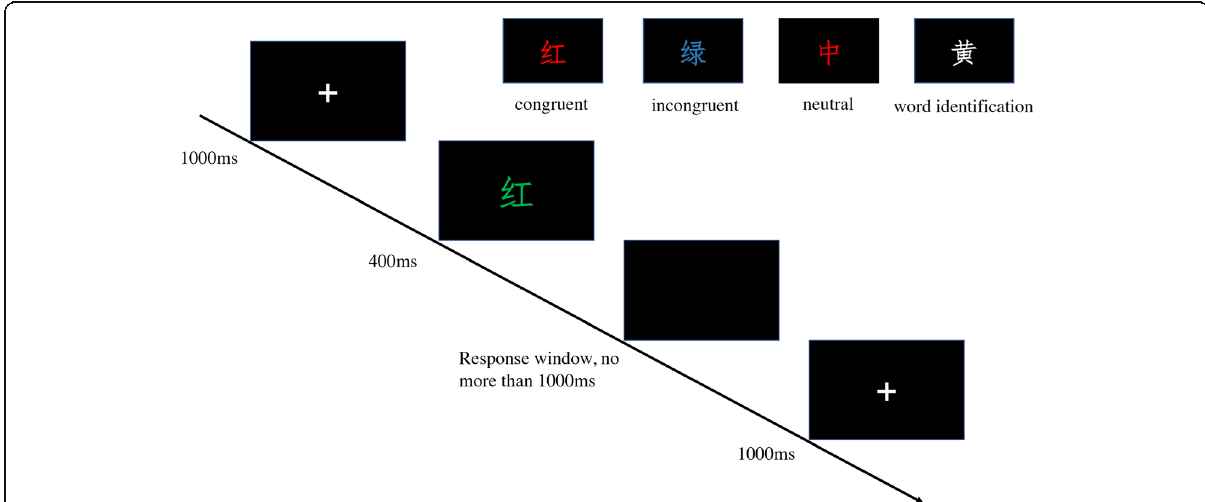
Fig. 1 The Stroop task paradigm. During the test phase, four kinds of trials were presented randomly against a black background: congruent (e.g., “ RED ” printed in red letters), incongruent (e.g., “ GREEN ” in blue letters), neutral (e.g., “ ZHONG ” in blue), and word identification trials (e.g., “ YELLOW ” in white letters). In the word identification trials, participants were instructed to press the key identifying the meaning of the word, whereas they responded to the color of the word in other kinds of